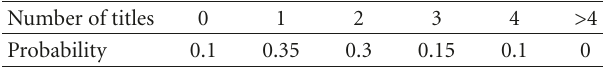
Table 2: Model used in analyses here of probability of number of video streams per IP video subscriber in the busy hour (prime time). Average = 1.8 streams per